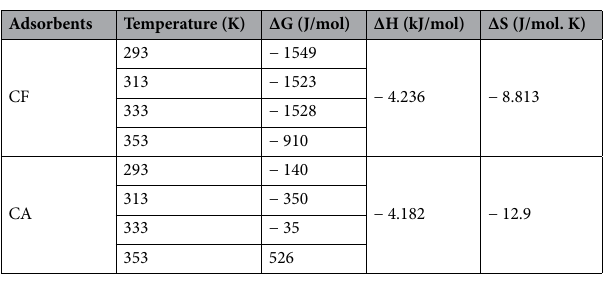
Table 4. Thermodynamic parameters for adsorption of disperse red 60 dye onto CF and CA.